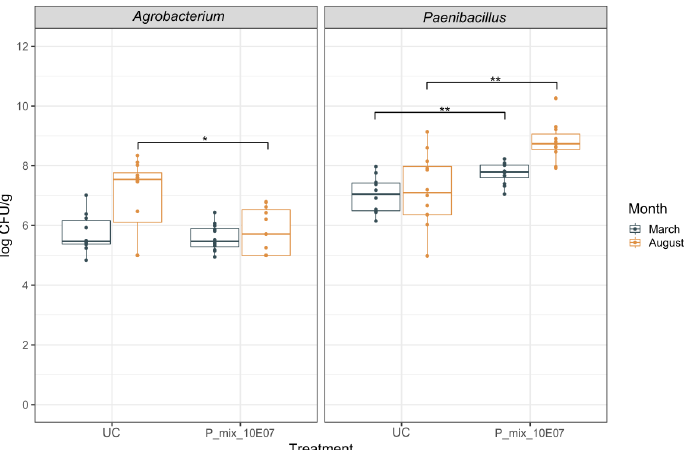
Figure 2. Population densities of rhizogenic Agrobacterium and Paenibacillus in tomato root samples at the beginning and towards the end of the 2019 greenhouse trial. The boxplots present the popu- lation density of rhizogenic Agrobacterium and Paenibacillus at the beginning (March) and towards the end of the trial (August) in root samples of untreated plants and plants treated with a BCO